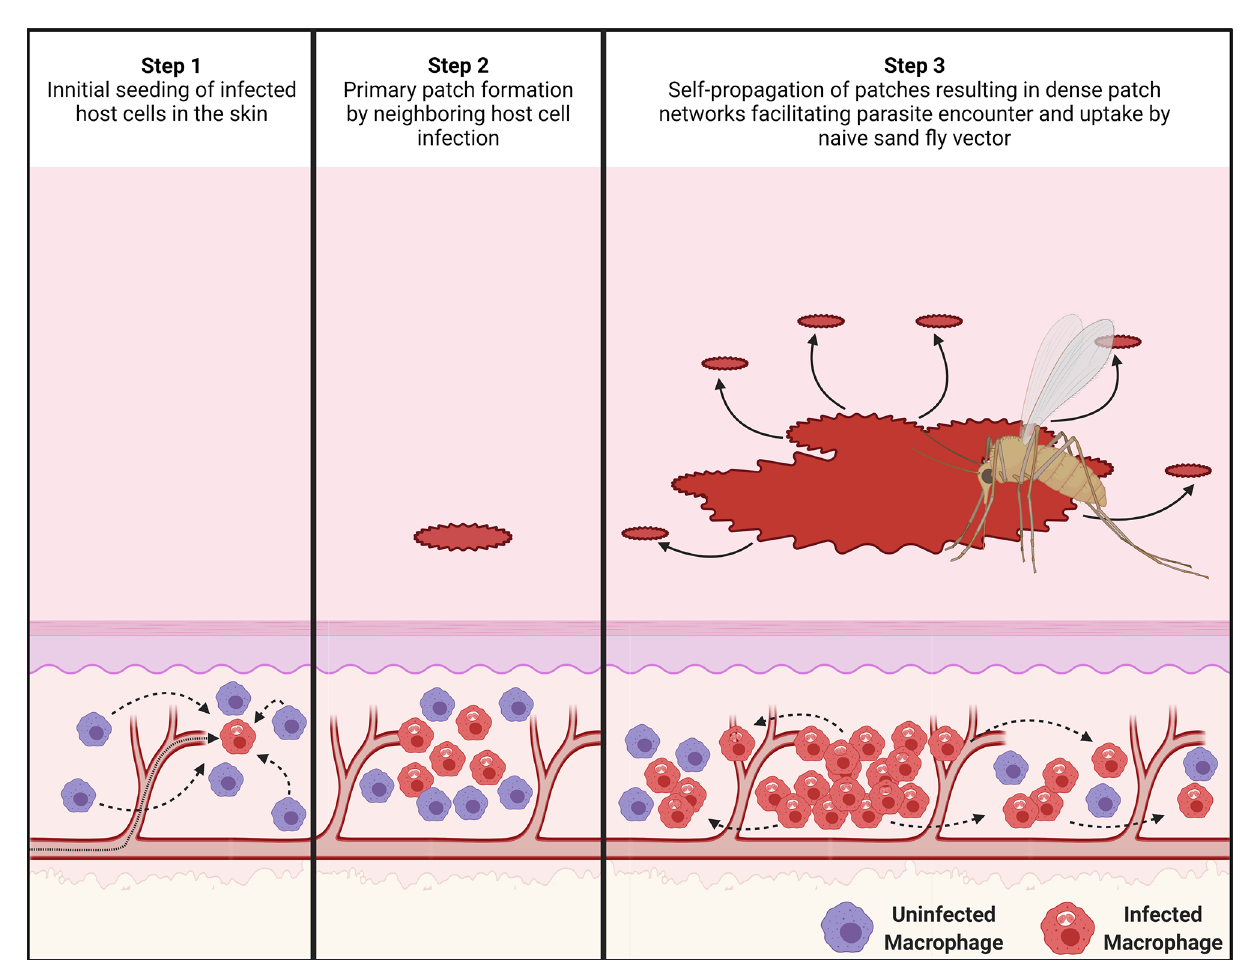
FIGURE 6 | Proposed mechanism for the dispersal of patches of L. donovani -infected myeloid cells. (Step 1) After an initial seeding event of Leishmania amastigote- infected host cells (in red) in the skin from the circulation, uninfected phagocytic cells (in purple) in the skin are attracted to the infected cells. (Step 2) These recruited myeloid cells form a type of innate granuloma in which suitable uninfected myeloid cells are gradually infected. This results in the formation of a primary patch of infected myeloid cells. (Step 3) As these patches keep growing, they seed new patches within a radius “ r ” around themselves, potentially by escape of infected myeloid cells or via transient release of free amastigotes. This process then keeps repeating itself, forming self-propagating networks of patch “ clusters ” . The image was created with